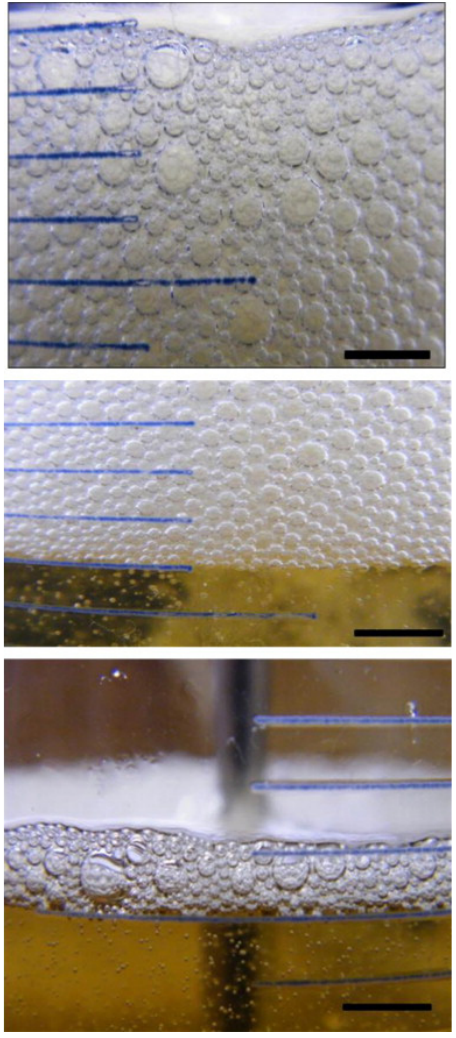
Figure 1. Optical images of the foam produced by a solution of 2 wt.% of additive D in base oil at 20 °C. Reproduced with permission [12]. Copyright © 2010 Elsevier B.V.